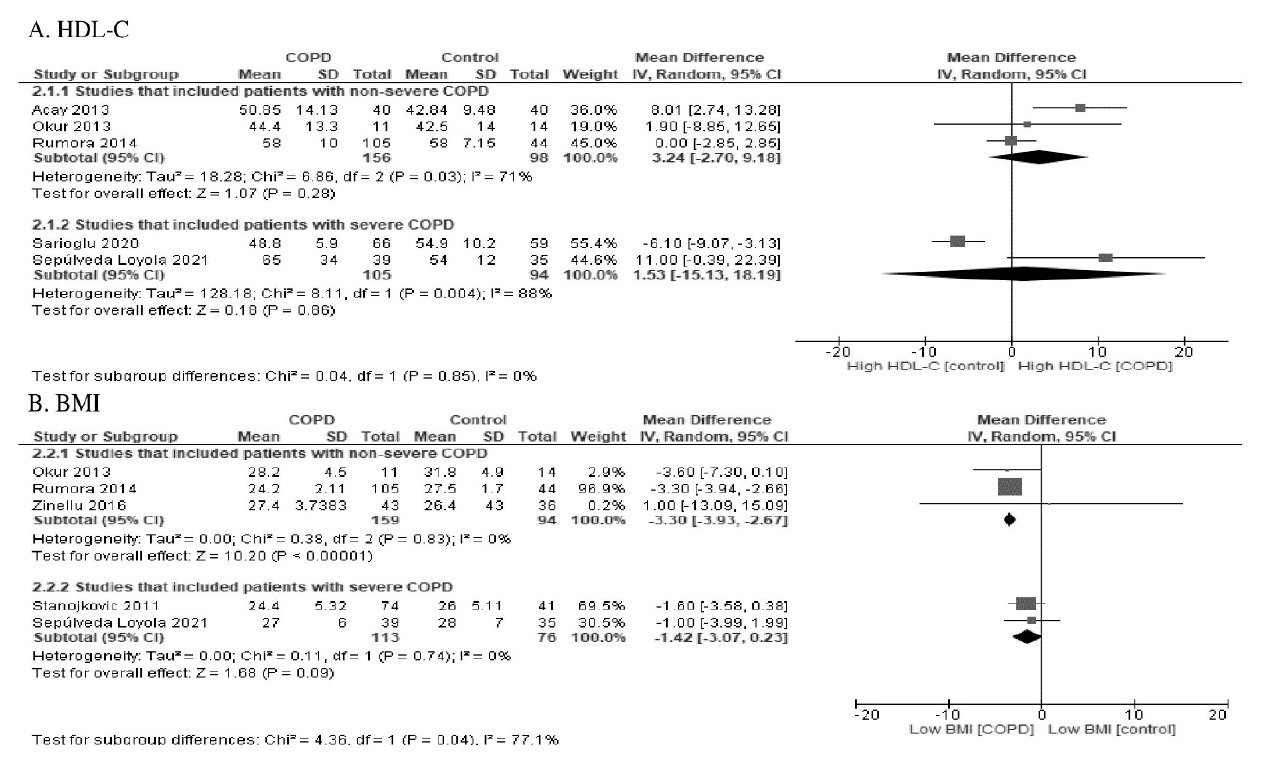
Figure 6. Forest plot of ( A ) high-density lipoprotein cholesterol and ( B ) body mass index stratified by the severity of